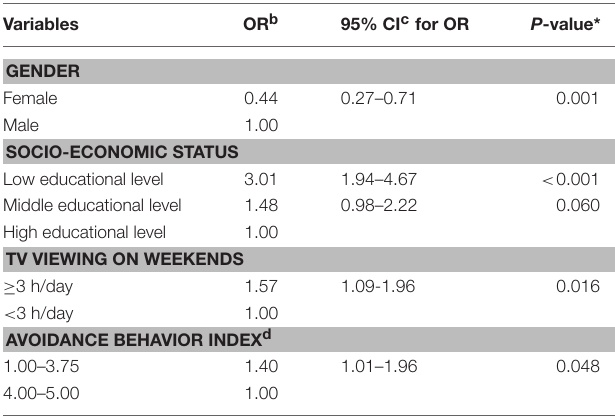
a Results of a forward stepwise logistic regression model. Only sign. associations are displayed. b OR, Odds ratio. c OR and 95% confidence interval are from forward regression analyses in which all independent variables listed were included in the model simultaneously. d Avoidance Behavior Index scores ranged from 1.00 to 5.00. Scores were dichotomized by median split. The lower the score, the more likely the participant had daily convenience behavior patterns. * P ≤